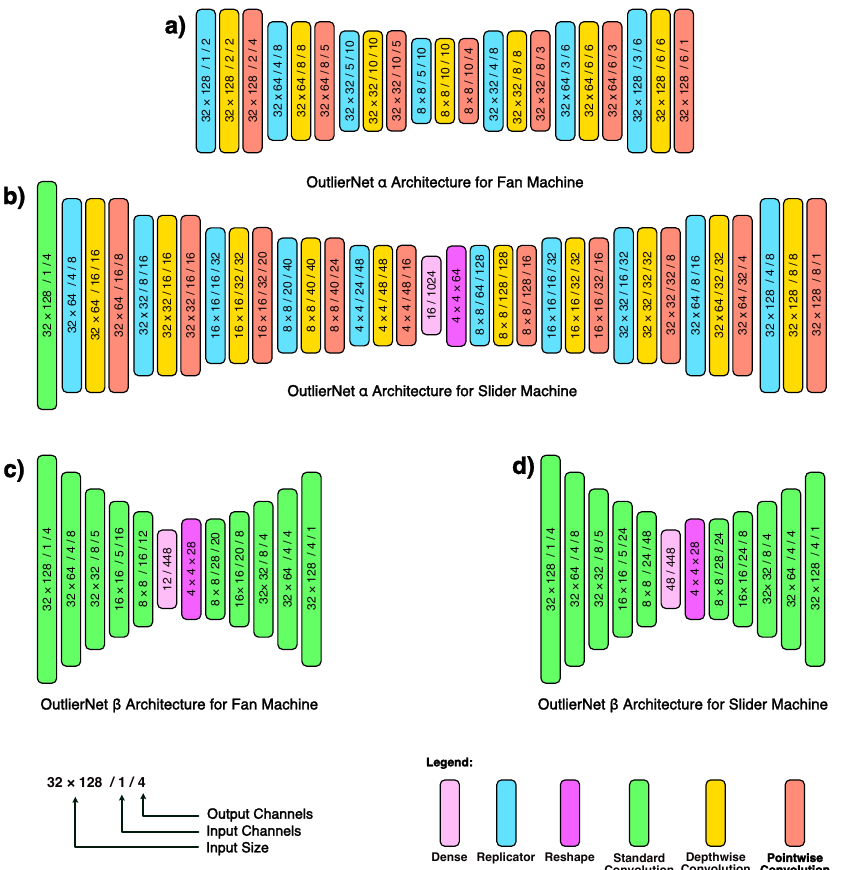
Figure 2. ( a ) Example of an OutlierNets α autoencoder architecture for fan AAD tasks (ID: 06, SNR: 6 dB) ( b ) Example of an OutlierNets α autoencoder architecture for slider AAD tasks (ID: 00, SNR: − 6 dB). ( c ) Example of OutlierNets β ID: 02, SNR: 0 dB architecture for fan AAD tasks (ID: 04, SNR: 6 dB). ( d ) Example of OutlierNets β architecture for slider AAD tasks (ID: 04, SNR: 6